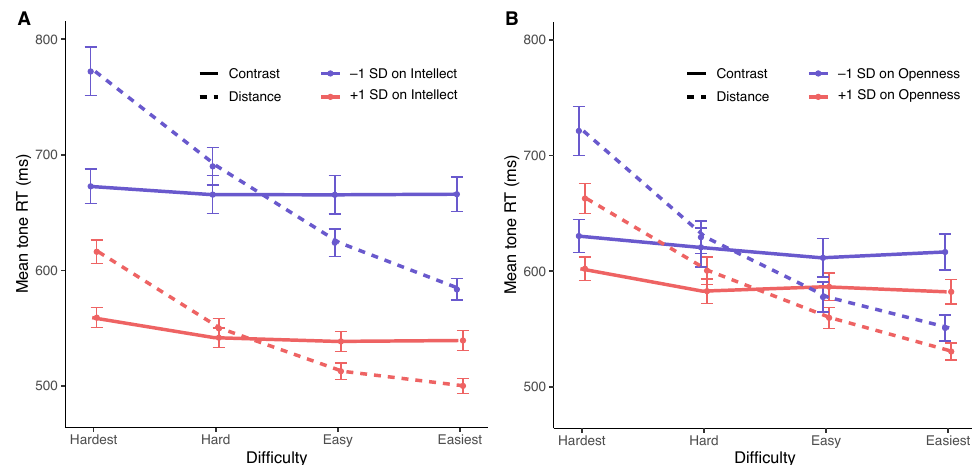
Figure A2. Mean tone-task RT for each condition for participants 1 SD and above and − 1 SD and below the group mean for Intellect ( A ) and Openness ( B ). Aspect scores represent standard scores. Error bars represent ± 1 standard error of the sample mean.